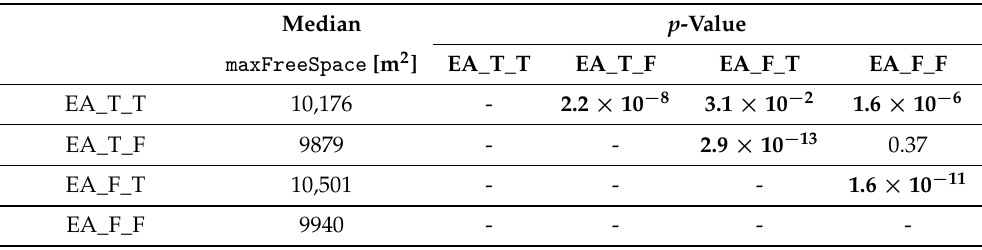
Table 1. Results for the single-objective case of Experiment 1 (variants = false vs. variants = true) and Experiment 2 (cooling = false vs. cooling = true). The median of the set of 100 best-of-run values is presented for each method plus the p -values calculated pairwise with the Wilcoxon rank-sum test. The statistically significant differences are highlighted in bold.